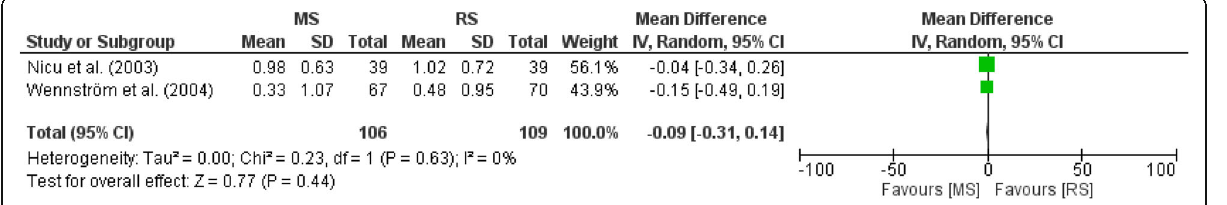
Fig. 6 Forest plot on differences in implant mean marginal bone loss between MS and RS groups in alle included